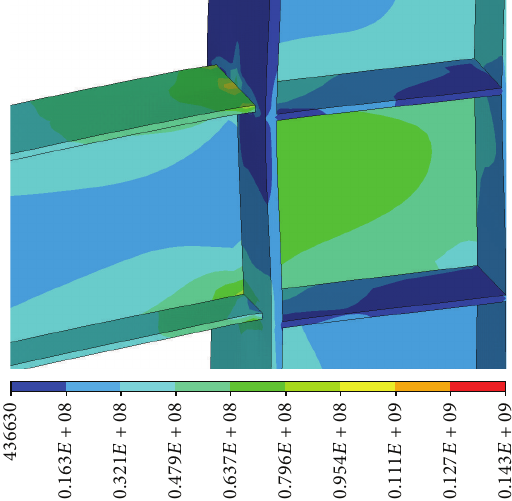
Figure 21: Stress of frame with traditional connection.